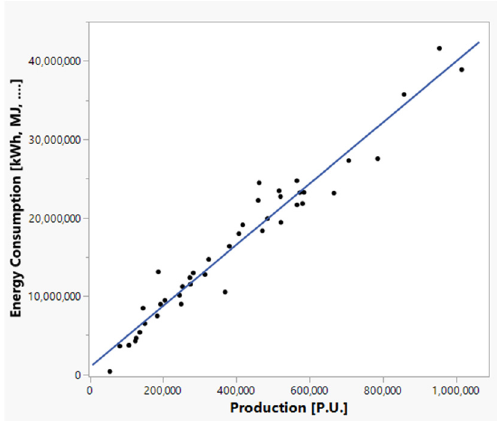
Figure 3. Linear regression between energy consumption [MJ] and production [P.U.].